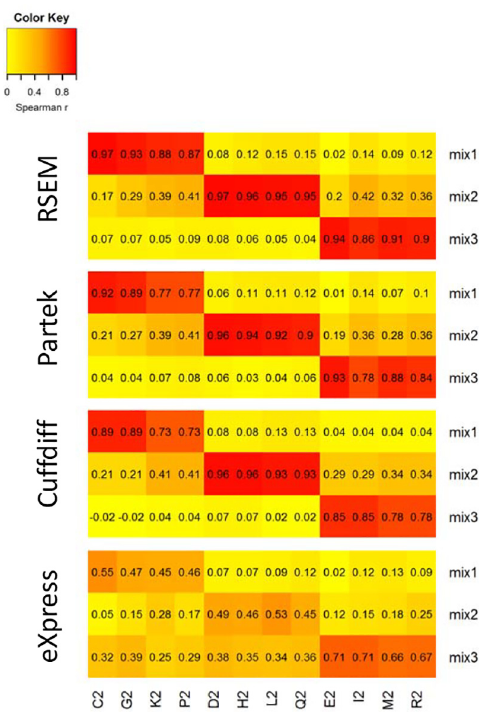
Fig 3. Spike-in correlations between expected versus observed values. Spike-ins Spearman correlation between concentration values (mix 1, mix 2, mix 3) and observed FPKM values. Sample names are shown in the figure and described in the S3